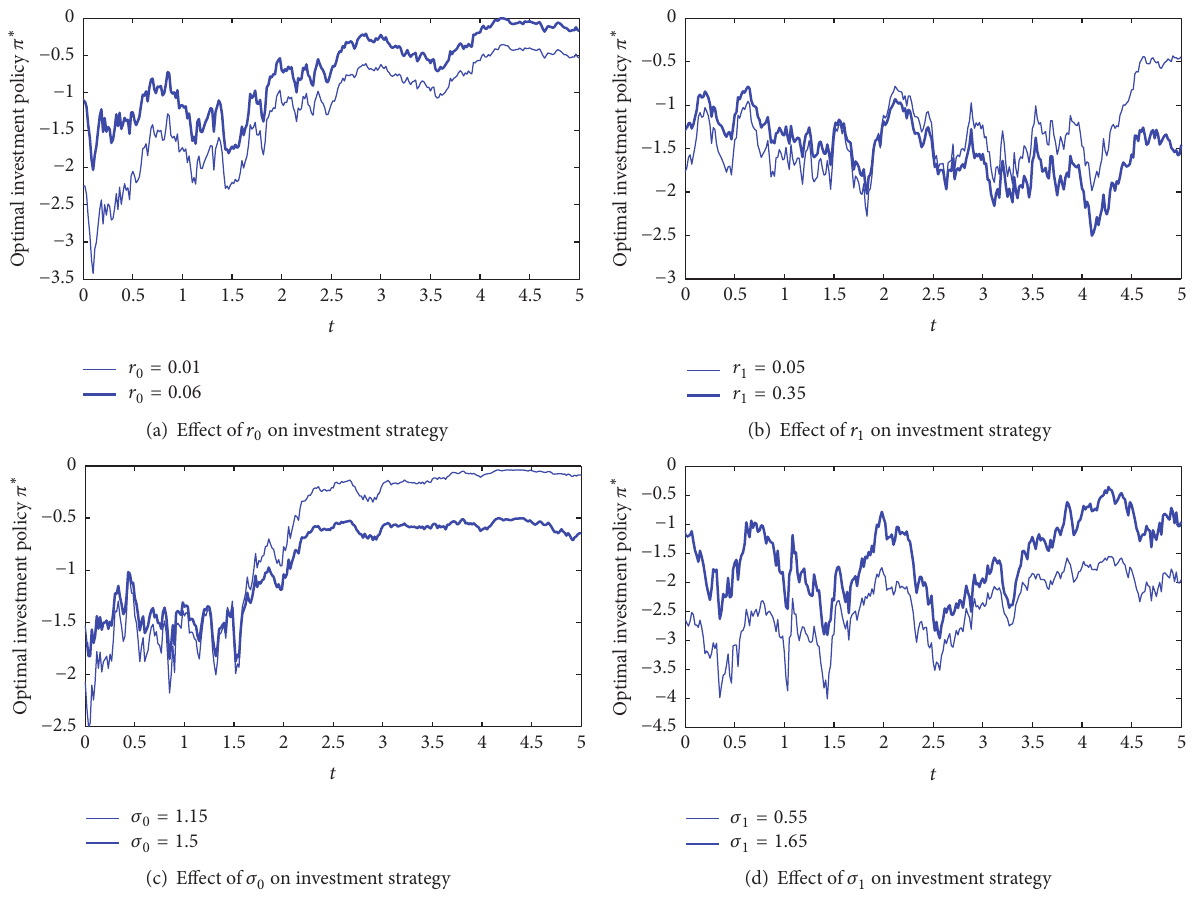
Figure 1: The effect of parameters on optimal investment